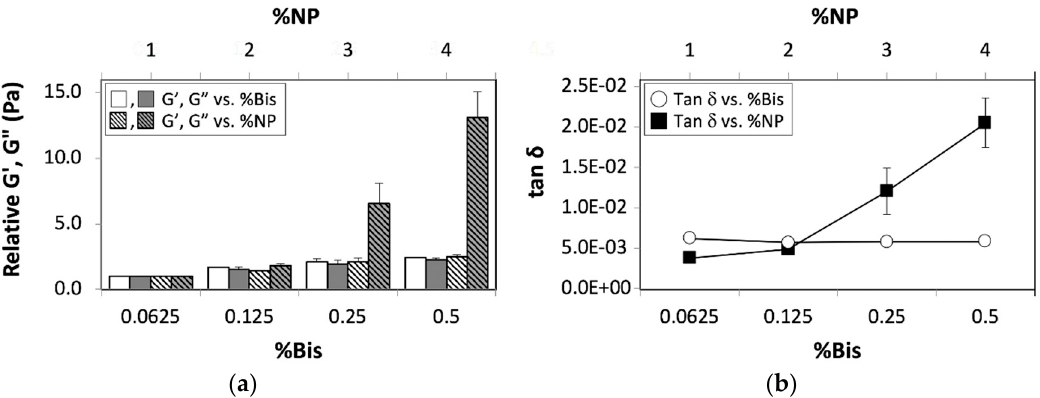
Figure 2. ( a ) Relative elastic (white bars) and viscous (grey bars) moduli of 5% pAAm hydrogels as a function of crosslinker concentration (%Bis) (solid bars) prepared using 1% 4 nm SiNPs and nanoparticle concentration (%NP) prepared using 0.0625% Bis (hashed bars), and ( b ) tan δ (ratio of G ″ /G ′ ) as a function of the crosslinker (white circles) and nanoparticle concentration (black squares). Data shown are the mean of triplicate measurements ± standard deviation and have been repeated at least three times with similar results.